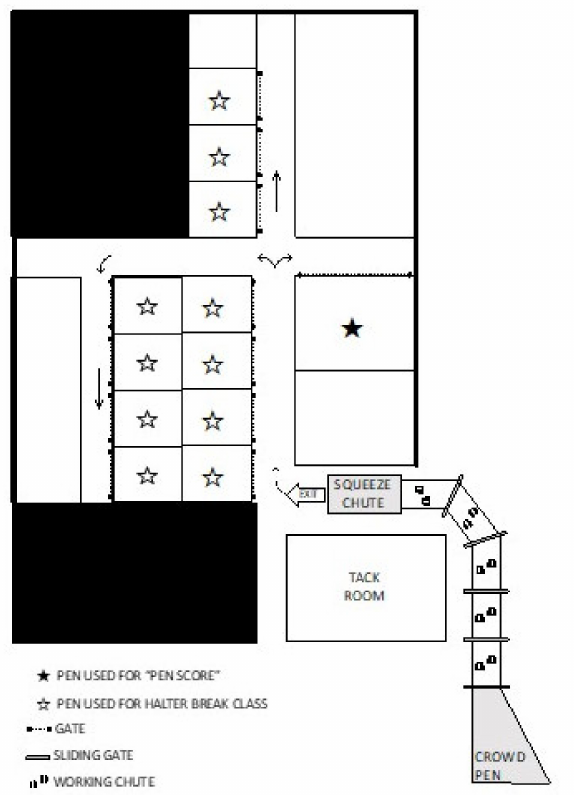
Figure 2. Corral layout at the university’s Beef Cattle Center. The arrows represent the direction that